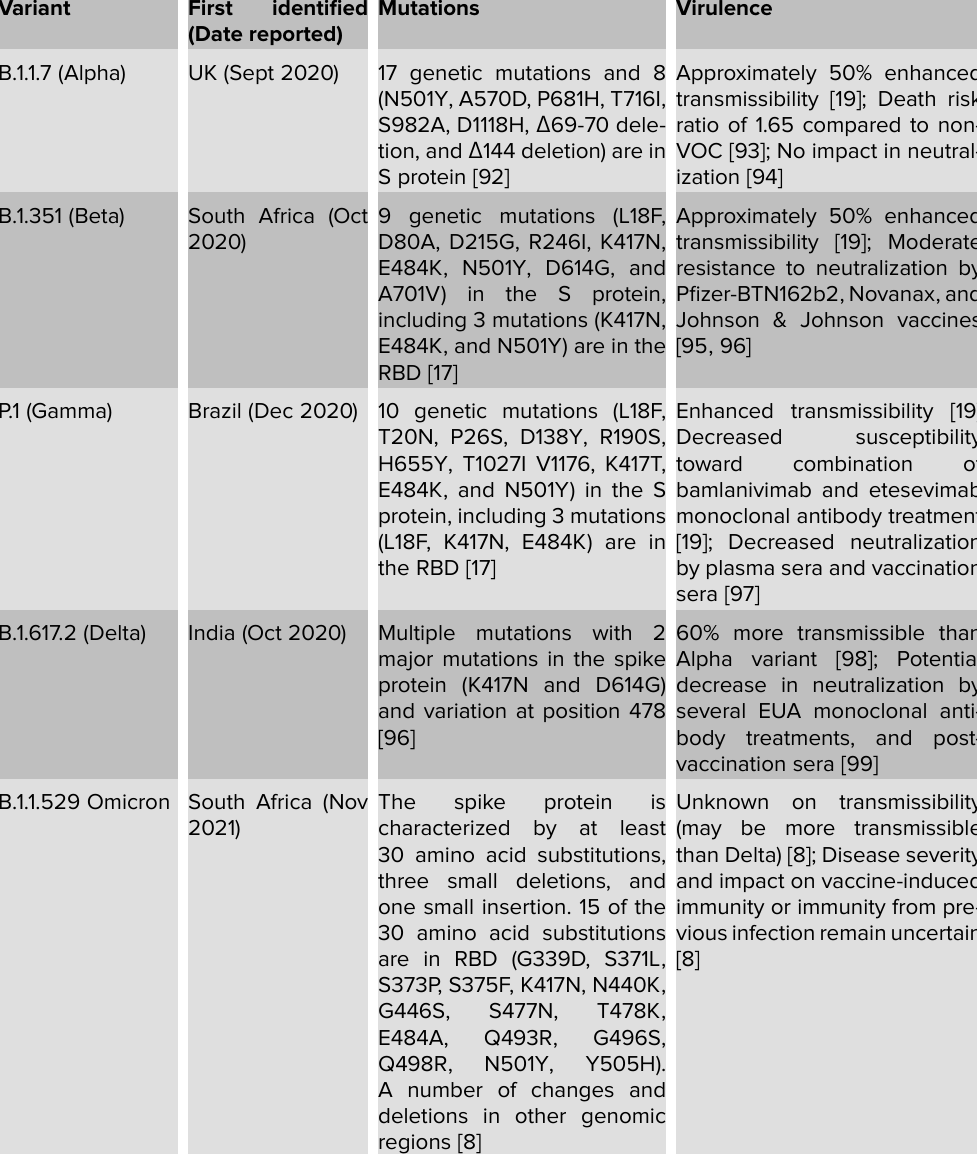
Table 1: Characteristics of variants of